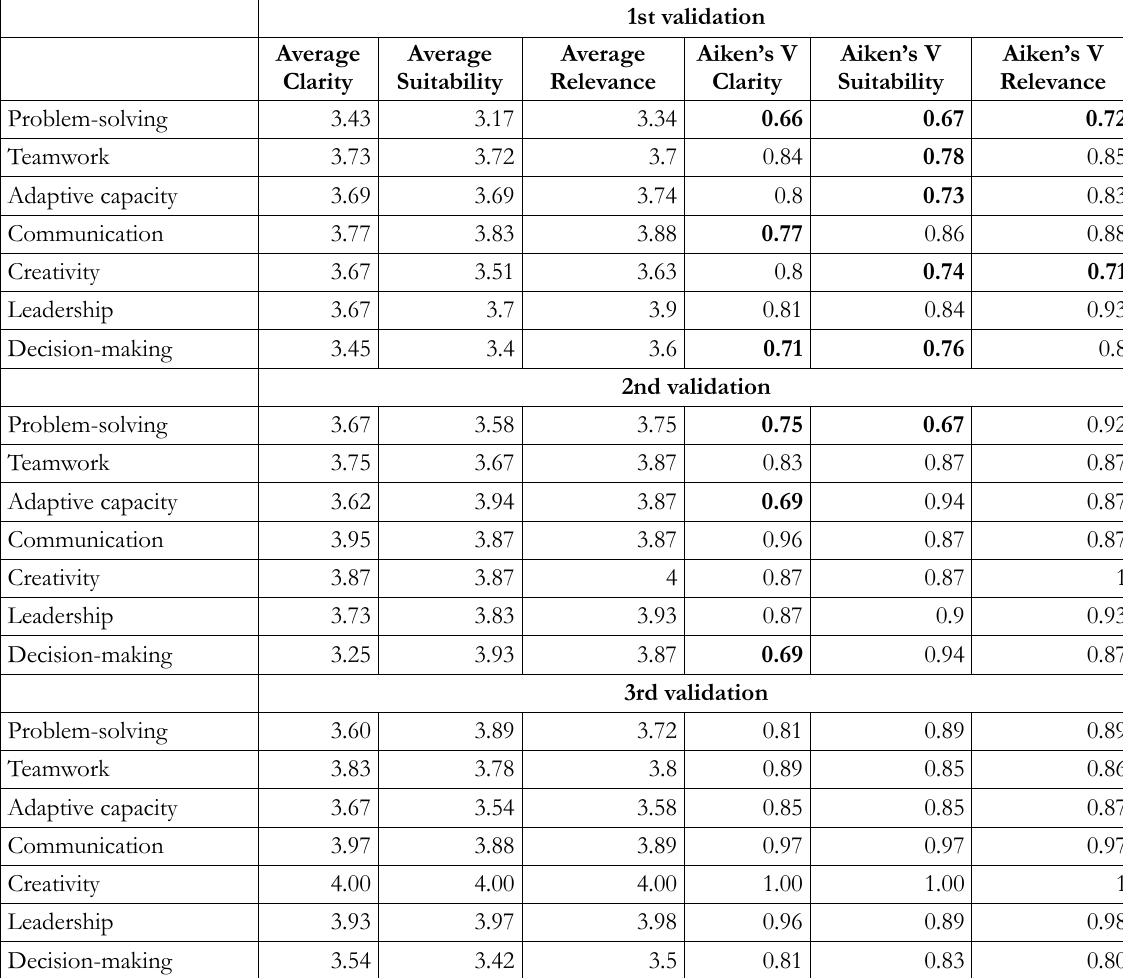
Table 2. Average values and Aiken’s V for every competency selected in each one of the three